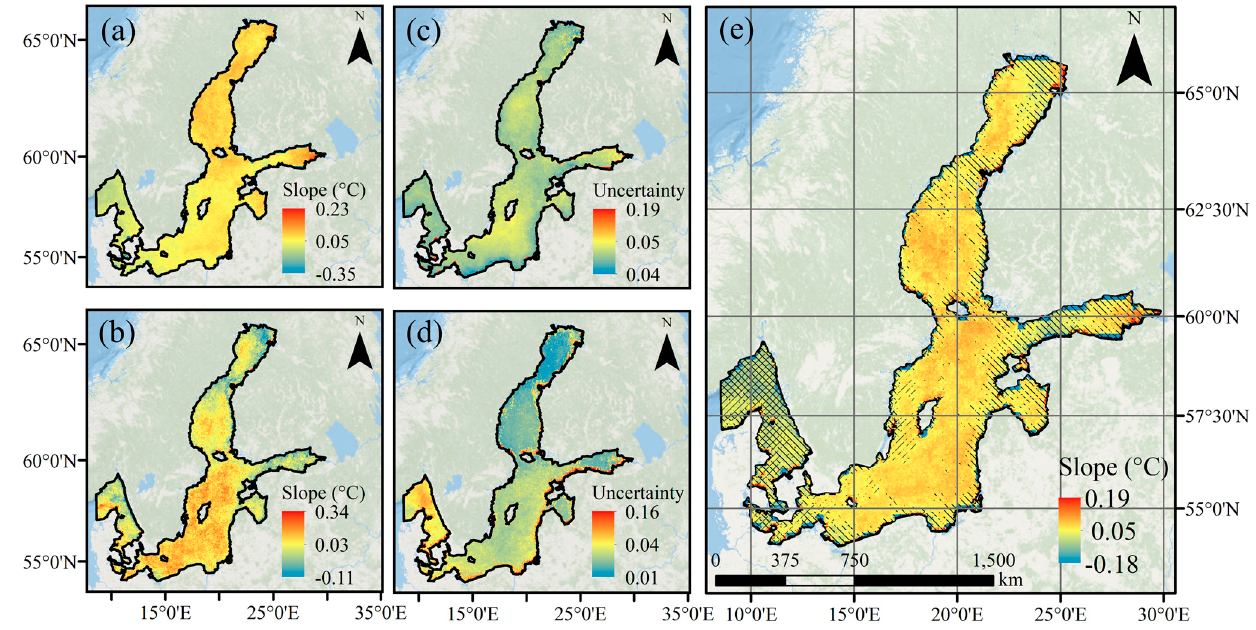
Figure 5. AVHRR Pathfinder sea surface temperature (SST) change slope magnitudes and associated uncertainties across the Baltic Sea over the last four decades calculated using ( a , c ) annual maximum, ( b , d ) annual minimum, and ( e ) the average slope magnitudes of both SST stacked series. Insignificant trends based on annual maximum and minimum SST are hatched with black lines at 45 and 135 degrees, respectively.